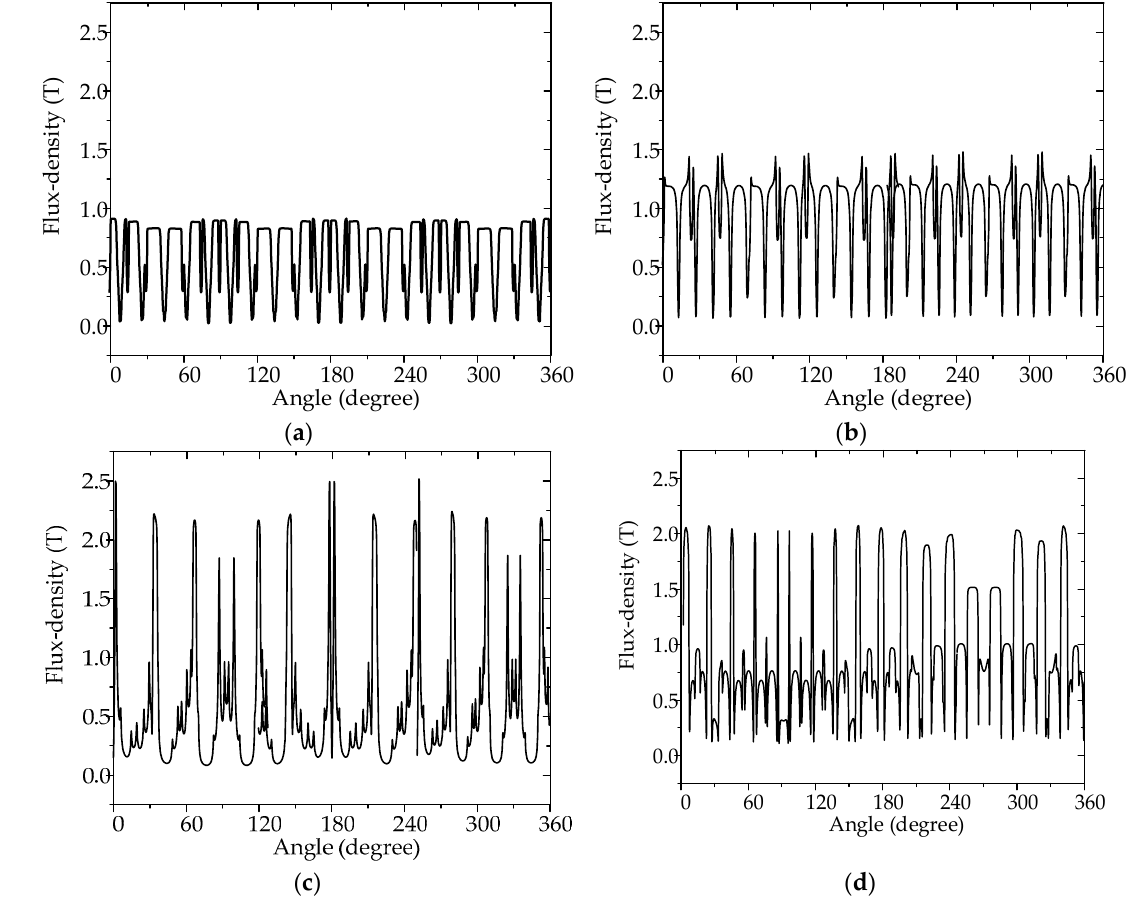
Figure 4. Airgap flux-density of proposed six-phase outer-rotor PM machines: ( a ) IPM type; ( b ) SPM type; ( c ) PMFS type; ( d ) PMV type.